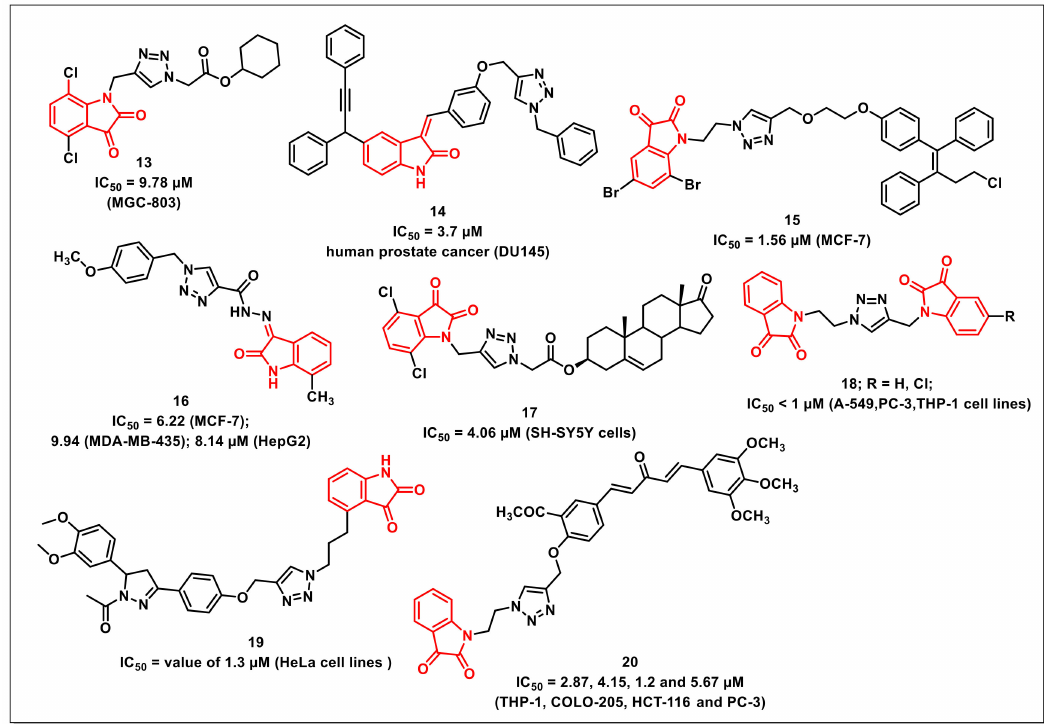
Figure 3. 1 H -1,2,3-triazole-based isatin compounds with antiproliferative